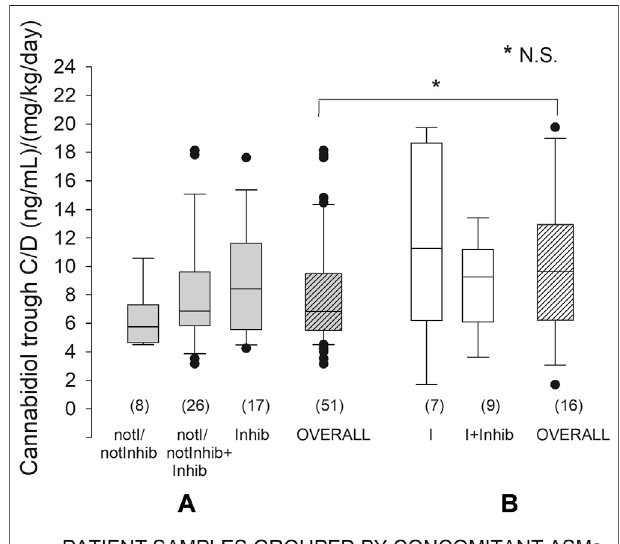
FIGURE 4 | Plasma concentration to weight-adjusted daily dose ratio of cannabidiol (C/D) from patients ’ specimens (n) grouped by concomitant antiseizure medication (ASM): (A) patients not receiving strong inducers; (B) patients receiving strong inducers. Box plots depict the range between the 25 th and 75 th percentiles of the data. The horizontal line marks the median value; capped bars indicate 10 th – 90 th percentiles. Black circles represent outlying values. p , signi fi cance of comparison between the two overall treatmentgroups byMann-Whitney rank sum test; N.S., not signi fi cant ( p ≥ 0.05). NotI/notInhib, not strong enzyme inducers/not inhibitors; I, strong enzyme inducers; Inhib, enzyme